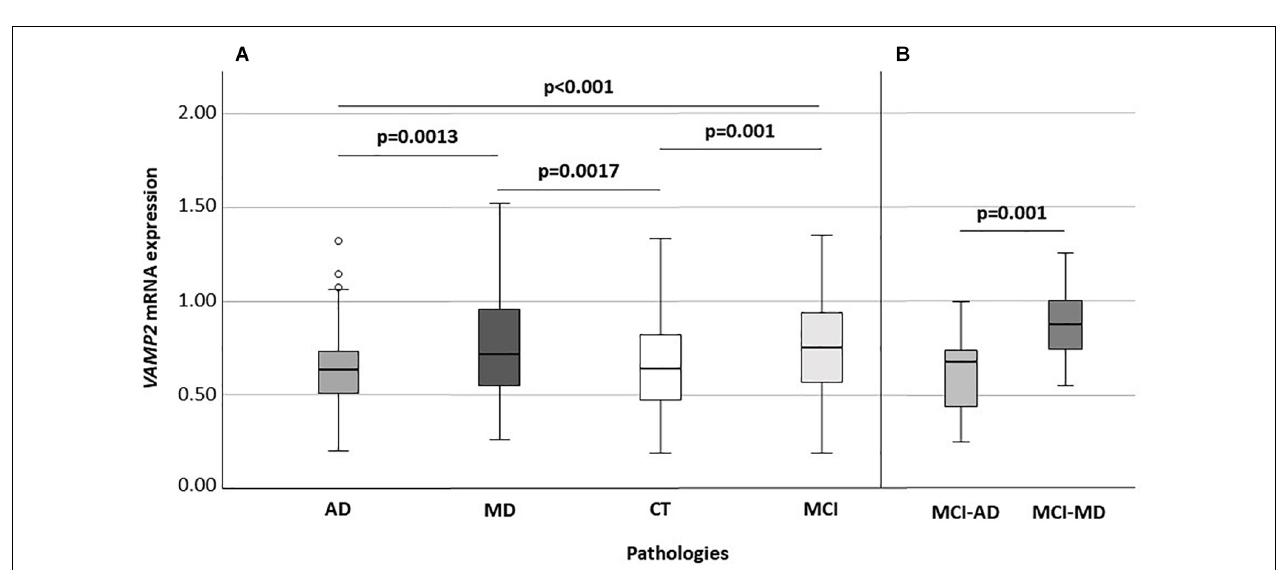
FIGURE 1 | VAMP2 mRNA expression according to VAMP2 26 bp Ins/Del polymorphism (A) and to VAMP2 26 bp minor allele Del (Ins/Del + Del/Del) (B) .